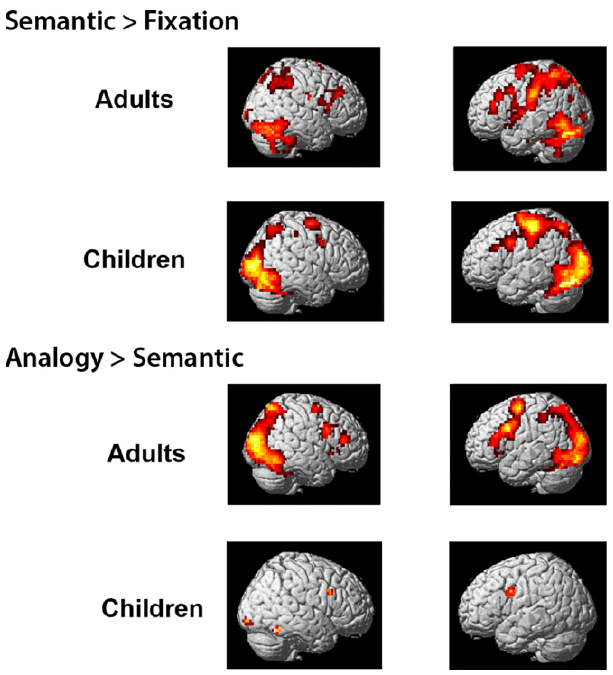
Figure S1. Whole-brain contrasts are displayed separately for adults and